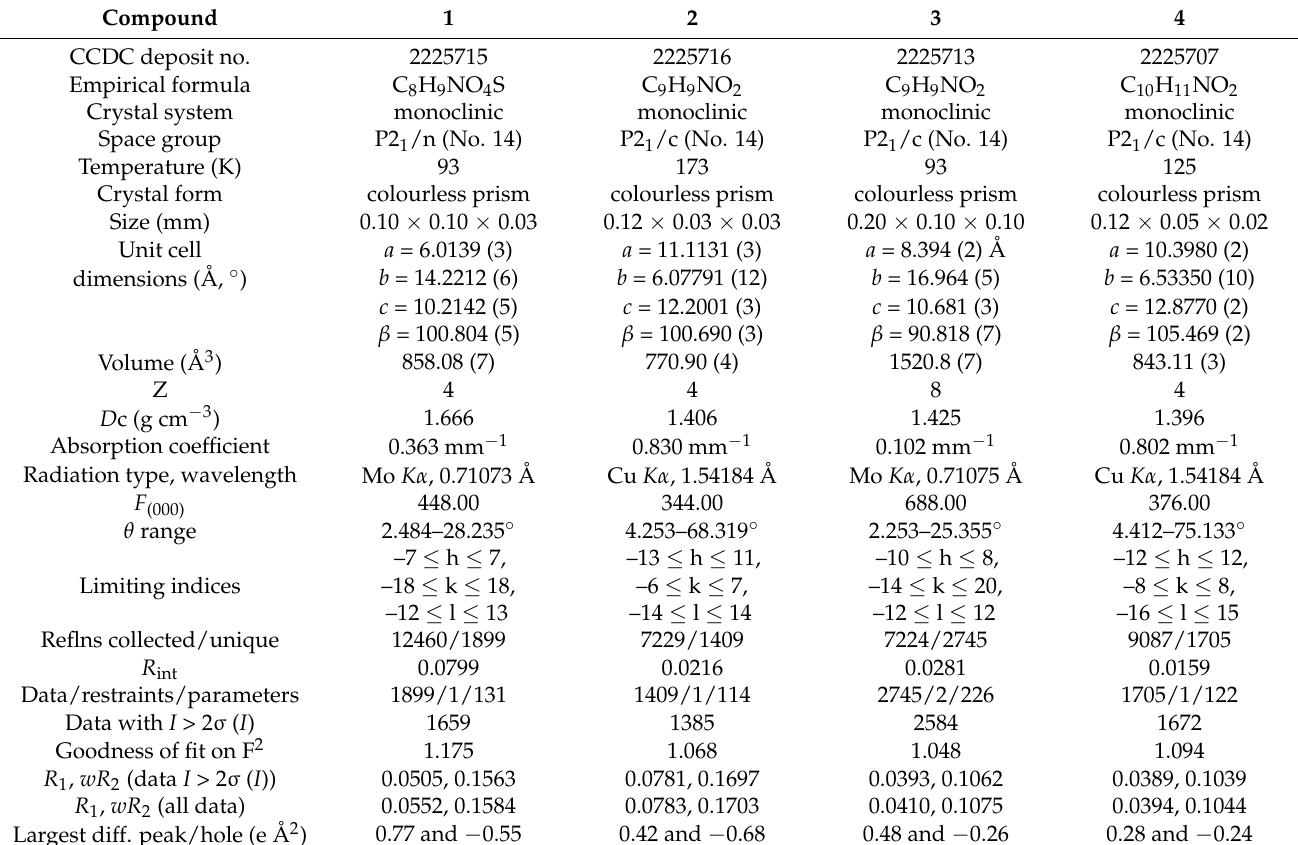
Table 1. Summary of crystallographic data obtained for compounds 1–4 .